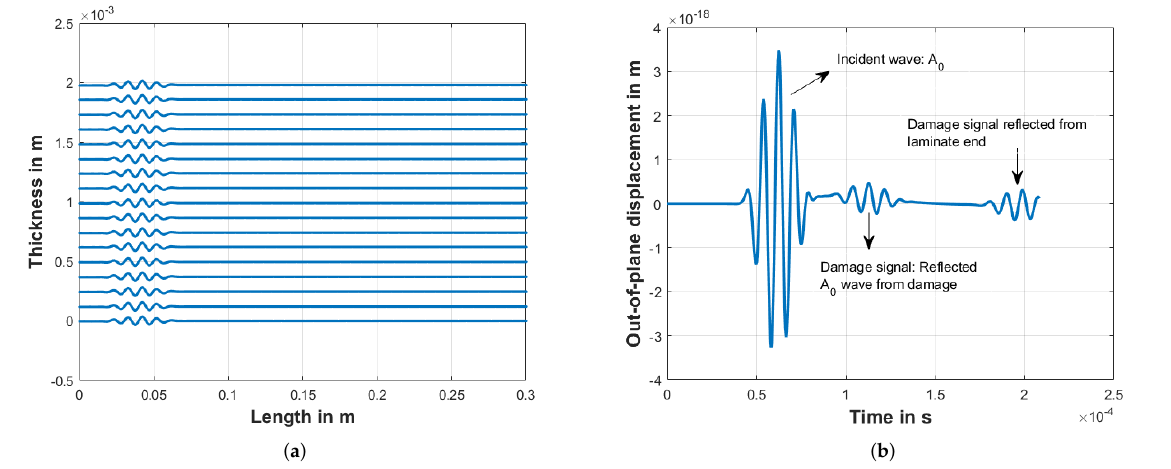
Figure 3. ( a ) Scaled displacement field over the cross-section of the FML at t = 50 µ s ( b ) displacement signal measured at the sensor